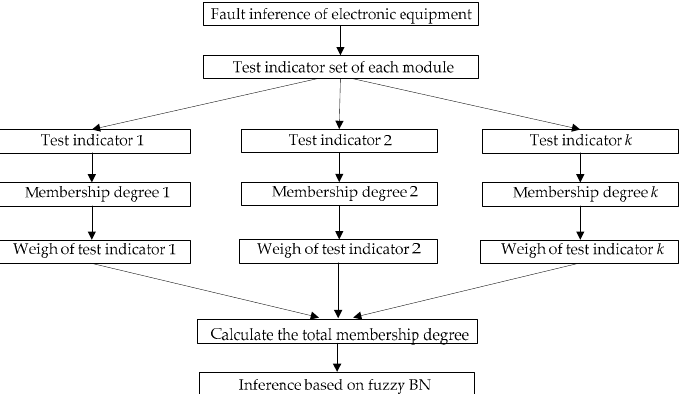
Figure 2. Flow chart of fault inference of multiple test indicators.